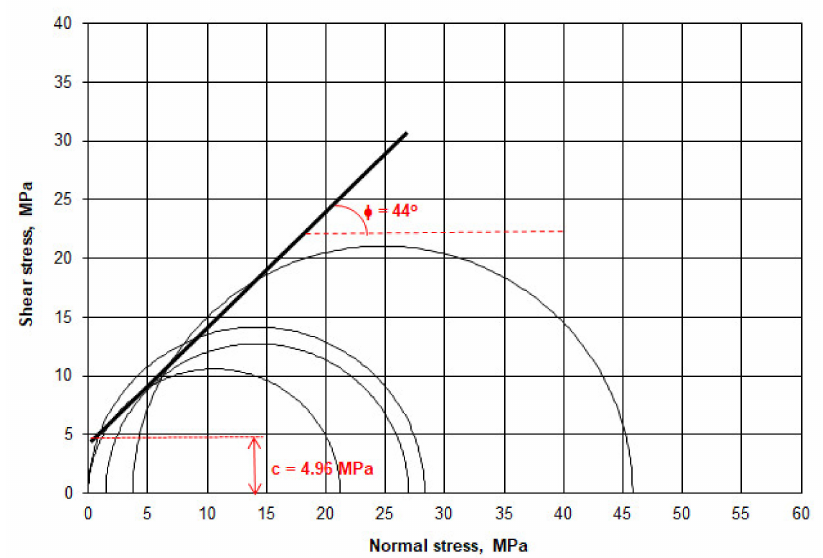
Figure 10. Mohr–Coulomb failure envelopes in terms of normal and shear stress for porosity of the zeolite-bearing rock n < 24%. The tangent line is composed according to best fit between σ 1p and σ 3. Determined parameters are c = 4.96 MPa and Φ = 44 ◦ .